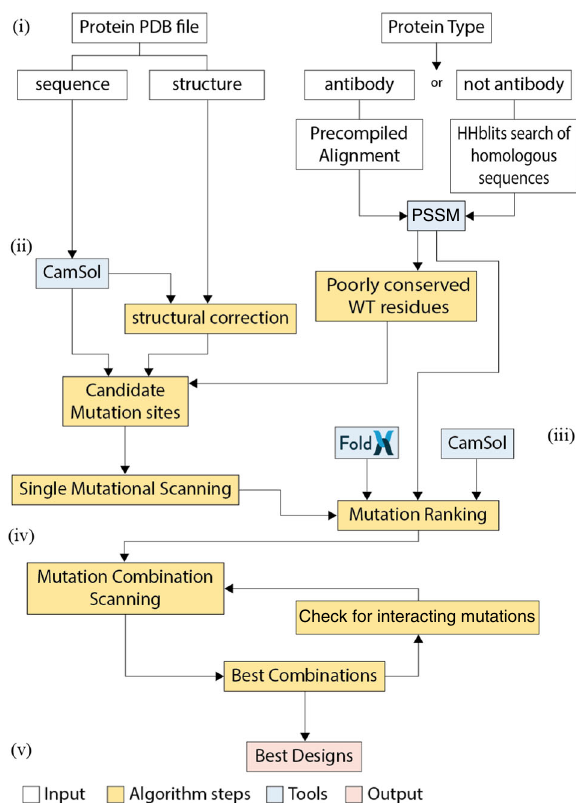
Fig. 2 | Schematic representation of the algorithm pipeline. Roman numbers refertothesubsectionsofthealgorithmpipelinesectioninthemaintext.Coloured in white are the input processing steps, inblue the toolsincluded in the algorithm, in yellow the core algorithm steps, and in red the